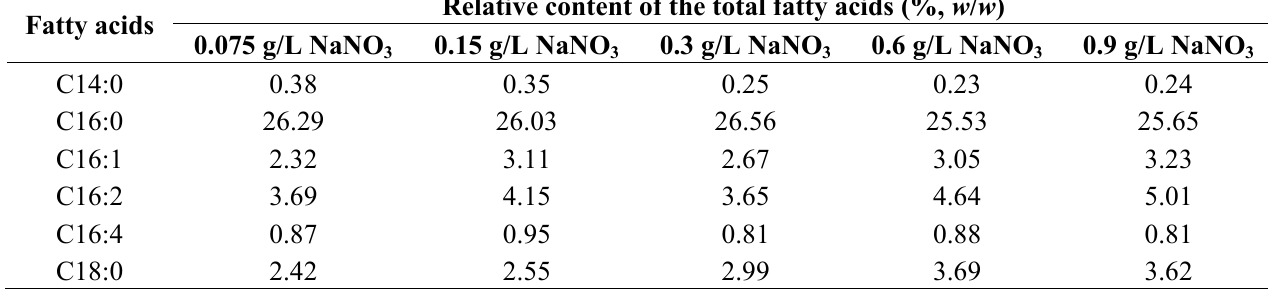
Table 2. Effects of initial NaNO Coelastrum sp.